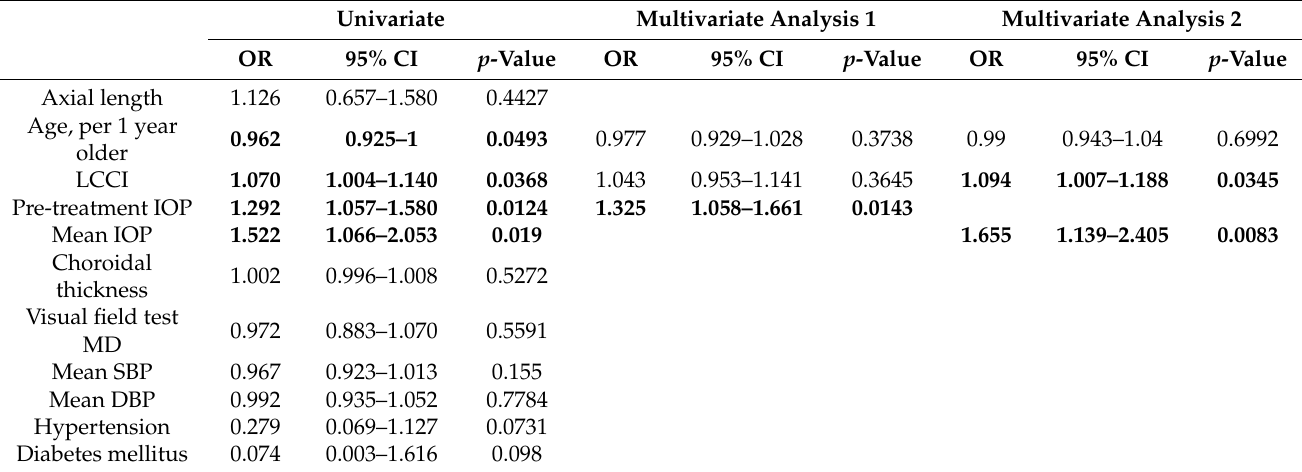
Table 2. Factors associated with retinal nerve fiber layer-dominant loss group (logistic